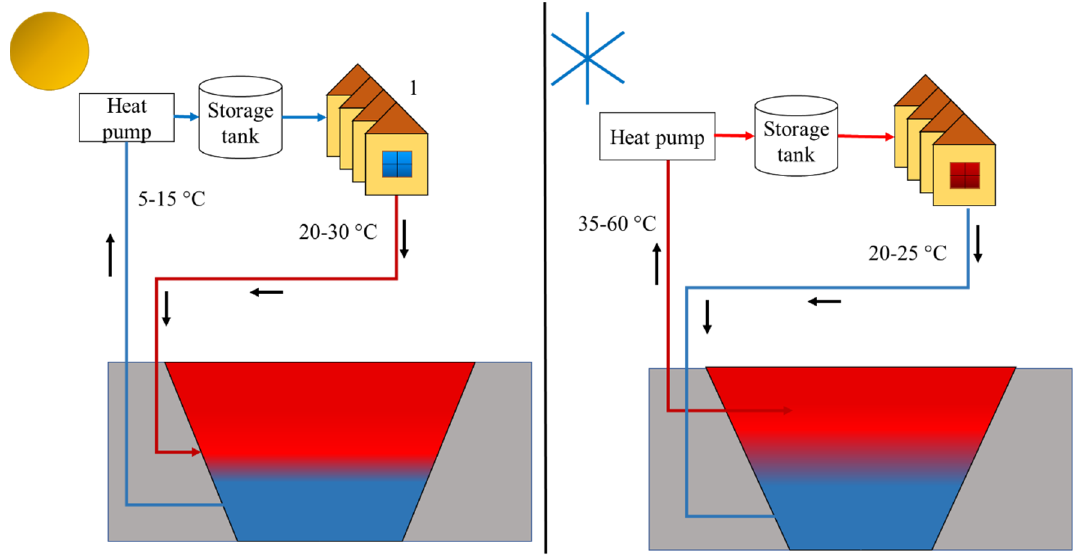
Figure 13. Seasonal pit storage in summer ( left ) and winter ( right ), 1—DH users. Hui et al. [121] investigated seven different absorption working pairs to find a feasible combination with convenient properties for seasonal storage of solar energy for a house heating system. These couples were CaCl 2 /H 2 O, glycerine/H 2 O, KOH/H 2 O, LiBr/H 2 O, LiCl/H 2 O, NaOH/H 2 O, and H 2 O/NH 3 . The analysis showed that none of the